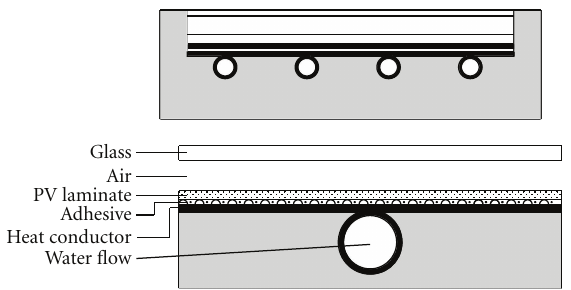
Figure 1: Sectional view of a glazed PVT collector.